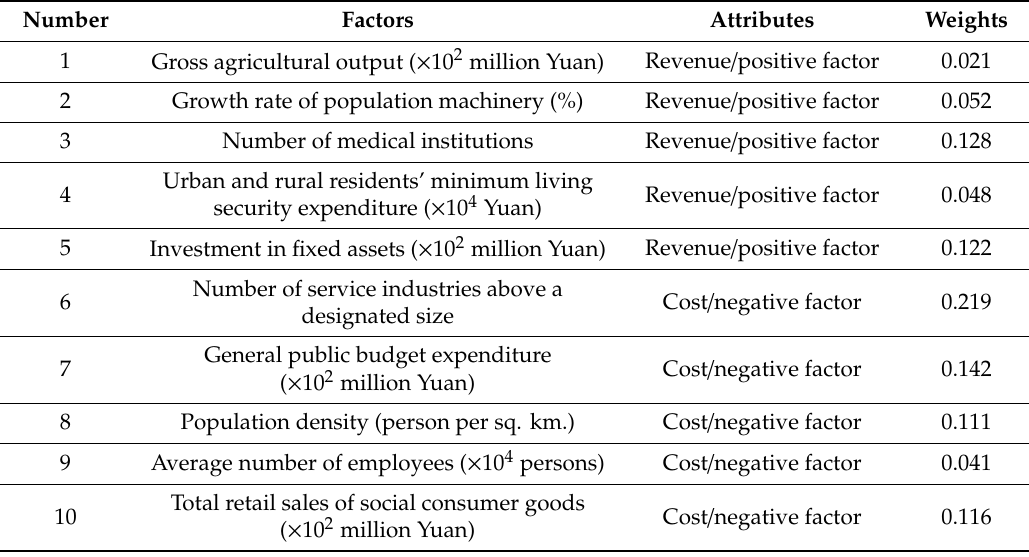
Table 2. Factor weights of external environment of ecological compensation for cultivated land